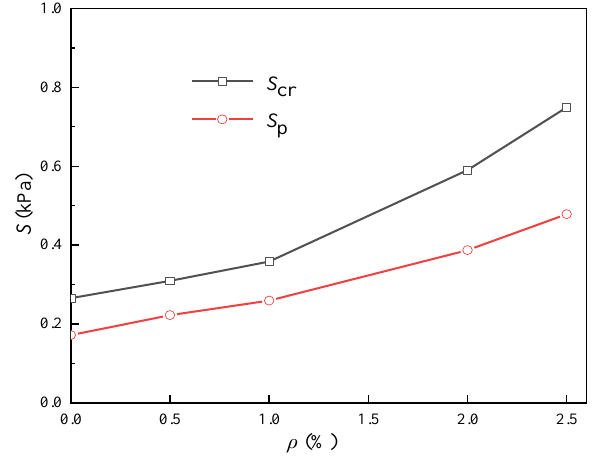
Figure 10. Influence of fiber volume fraction on the energy absorption capacity.